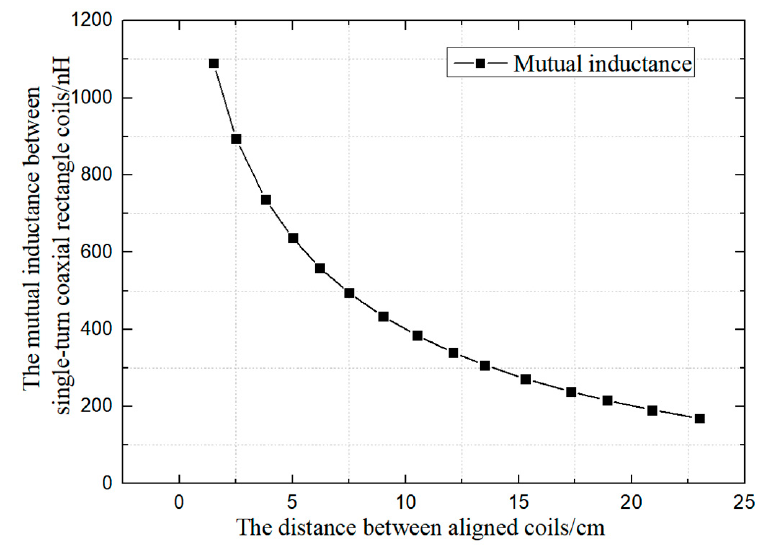
Figure 5. Calculation of coil mutual inductance based on Neumann Theory.